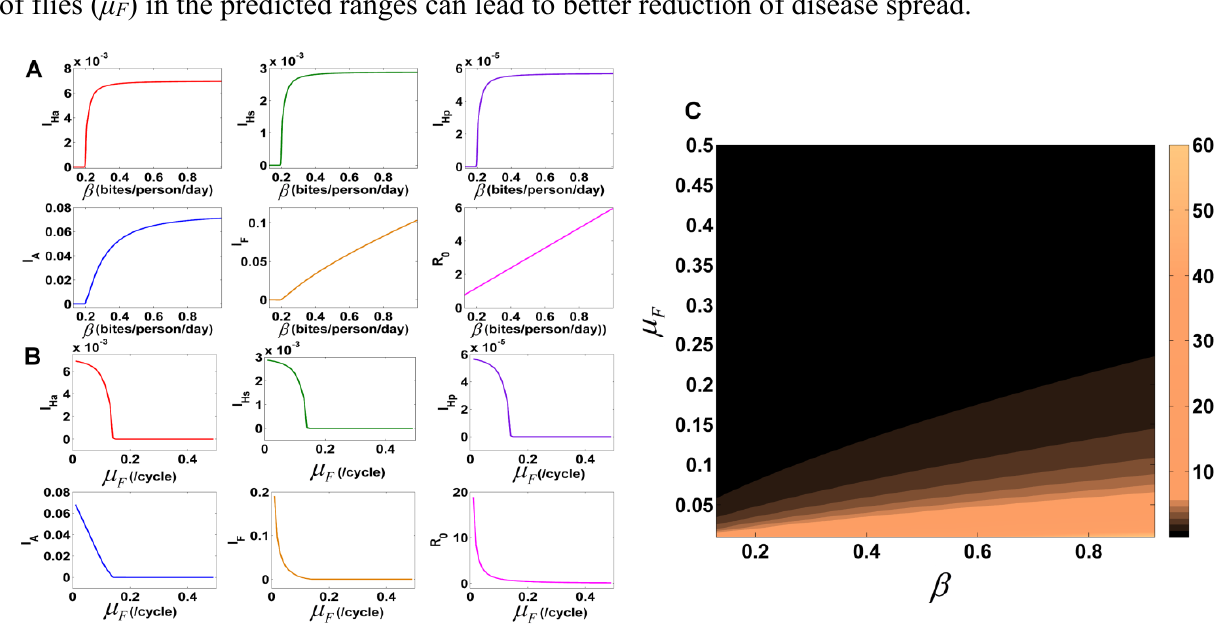
Figure 5. Parameter variations in β and μ F —( A ) Effect of β on equilibrium infection dynamics and R 0 ; ( B ) Effect of μ F on equilibrium infection dynamics and R 0 ; ( C ) Effect of simultaneous variations in β and μ F on R 0